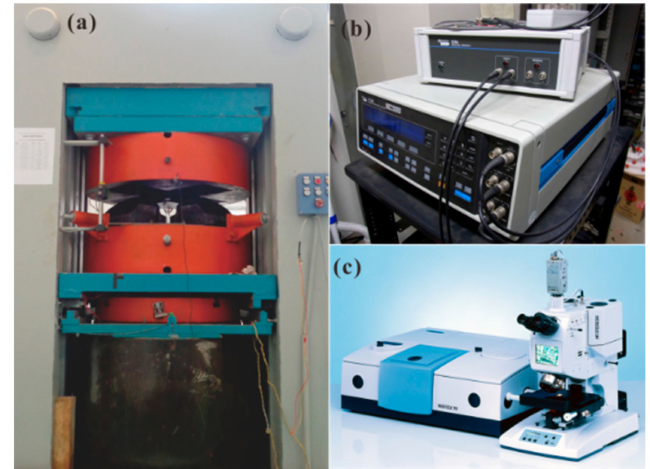
Figure 3. Experimental platform of HTHPSEI for electrical conductivity measurements of minerals and rocks at HP-HT conditions. ( a ) The pressure-generated apparatus of the YJ-3000t multi-anvil press; ( b ) the Solartron-1260 Impedance / Gain-phase analyzer used for measuring the complex impedance of the sample; ( c ) the Vertex-70v vacuum FTIR analyzer used to determine the water content before and after high-pressure EC